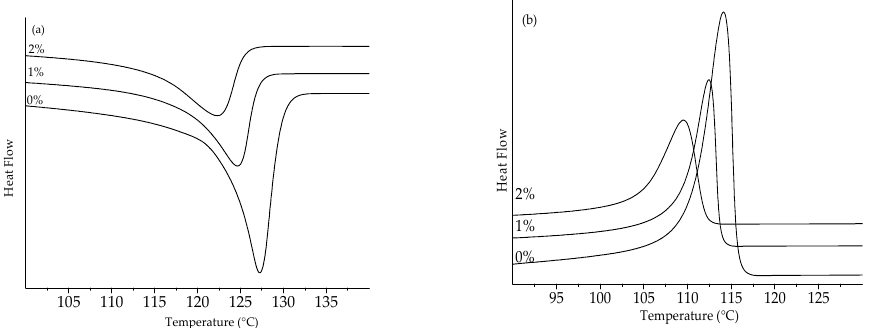
Figure 10. Thermograms of LLDPE peroxide: ( a ) melting peak and ( b ) crystallization peak.